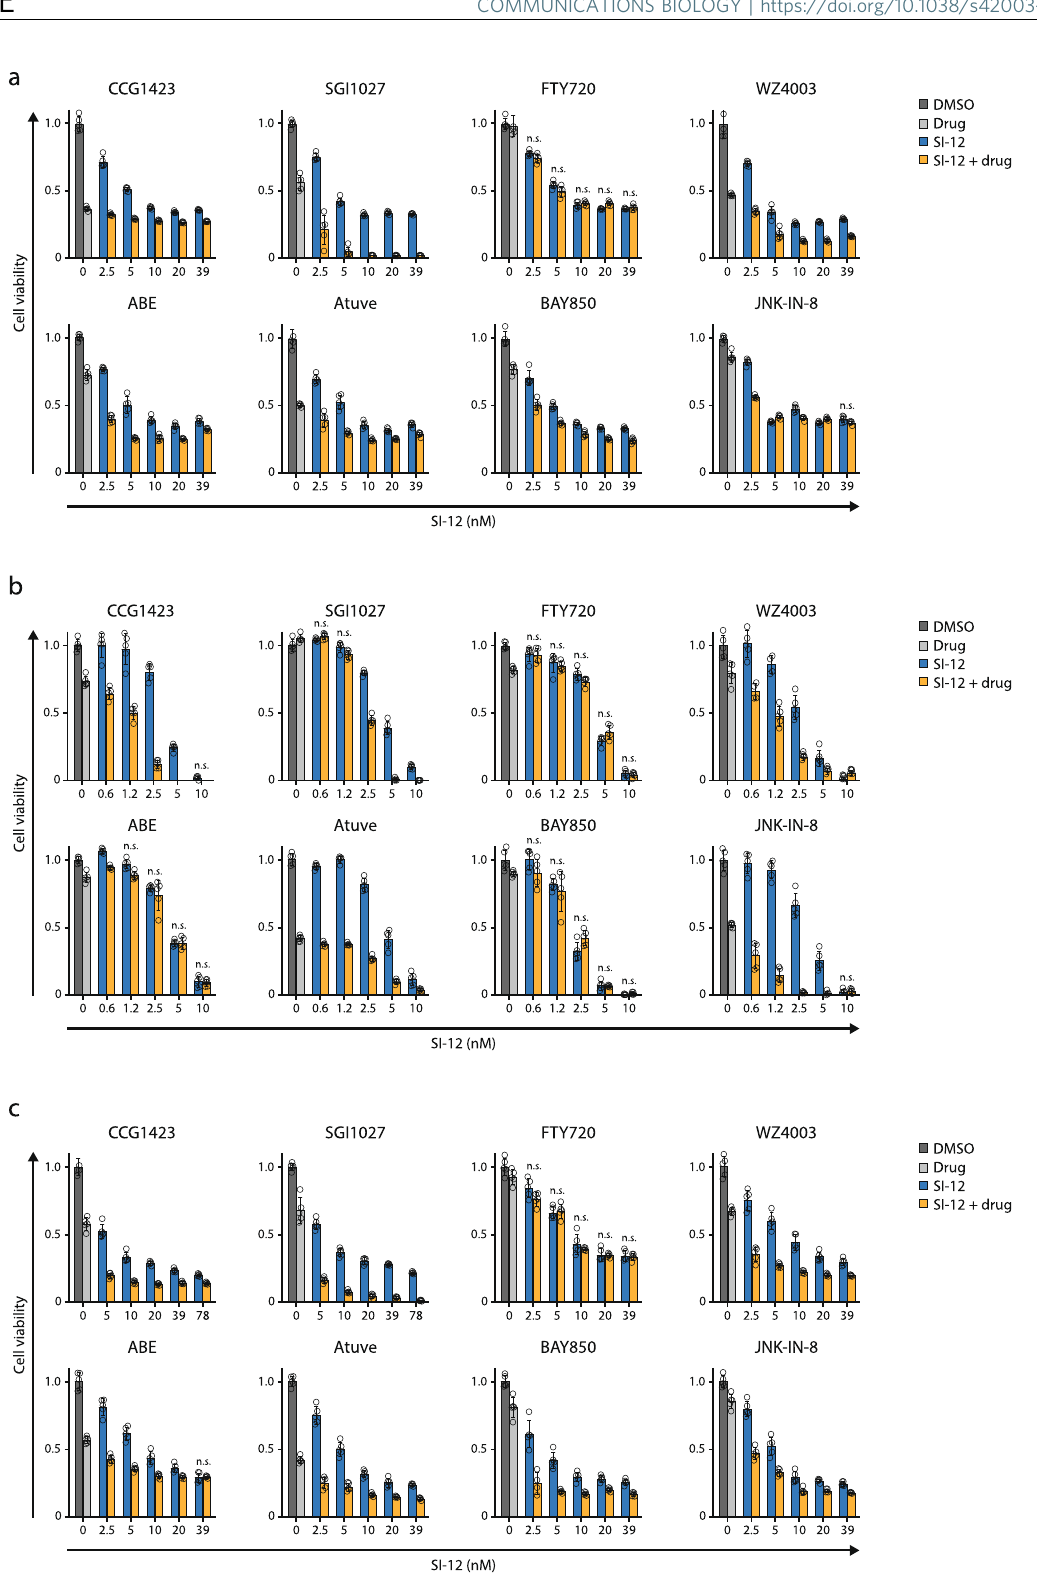
Fig. 5 In vitro drug combinations experiments in ER + BC cell lines. a In T47D cells. b In BT474 cells. c In ZR-75-1 cells. Cells were plated in 96 well plates and treated with the indicated compound(s) for 96 h. At the end of the drug treatment period, the cells were subjected to an MTS viability assay. For drug concentrations see Table 1. Each point re fl ects at least four technical replicates. Each cell viability plot represents at least 2 independent experiments showing similar results. Statistical signi fi cance compares between the combo and the most effective single agent (either SI-12 at relevant concentration, or the partner molecule). ***For all the results P < 0.0005, two-tailed Student ’ s t- test, if not mentioned otherwise. ns , not signi fi